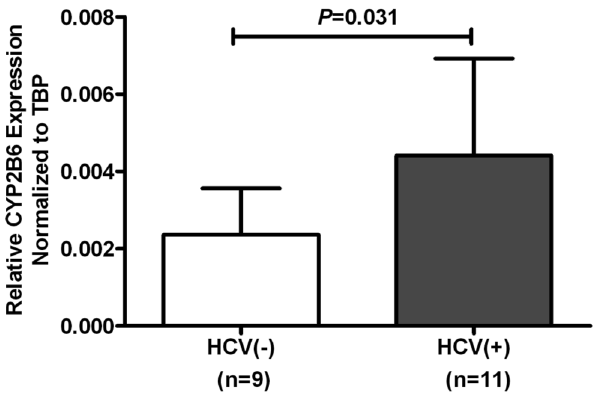
Figure 2. The relative CYP2B6 expression levels in EBV- transformed lymphoblastoids were compared between HCV antibody-positive (HCV( + )) and antibody-negative patients (HCV( 2 )). (The error bar represents the standard deviation; n, subject number).